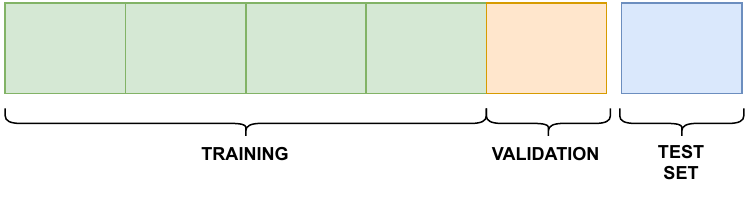
Figure 9. Experiment setup.